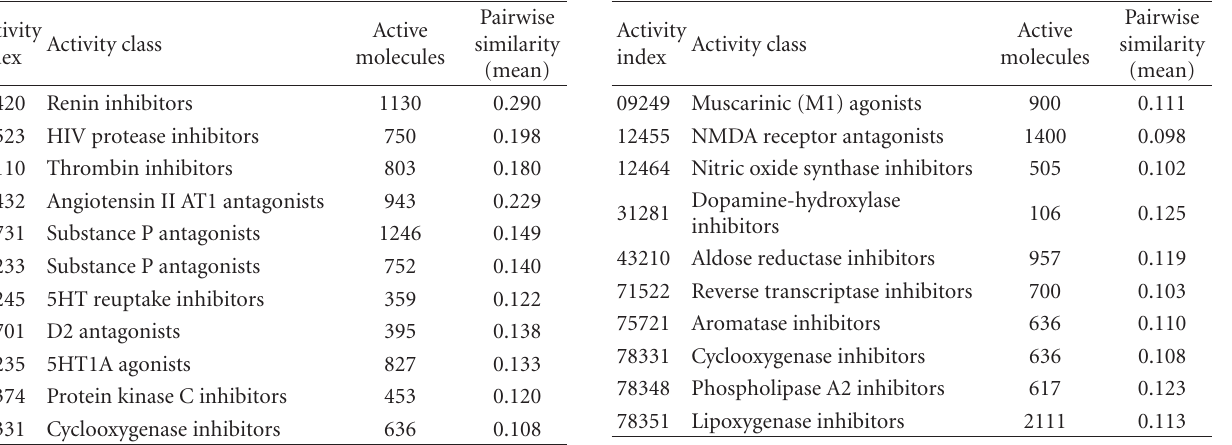
Table 1: MDDR activity classes for DS1 dataset.